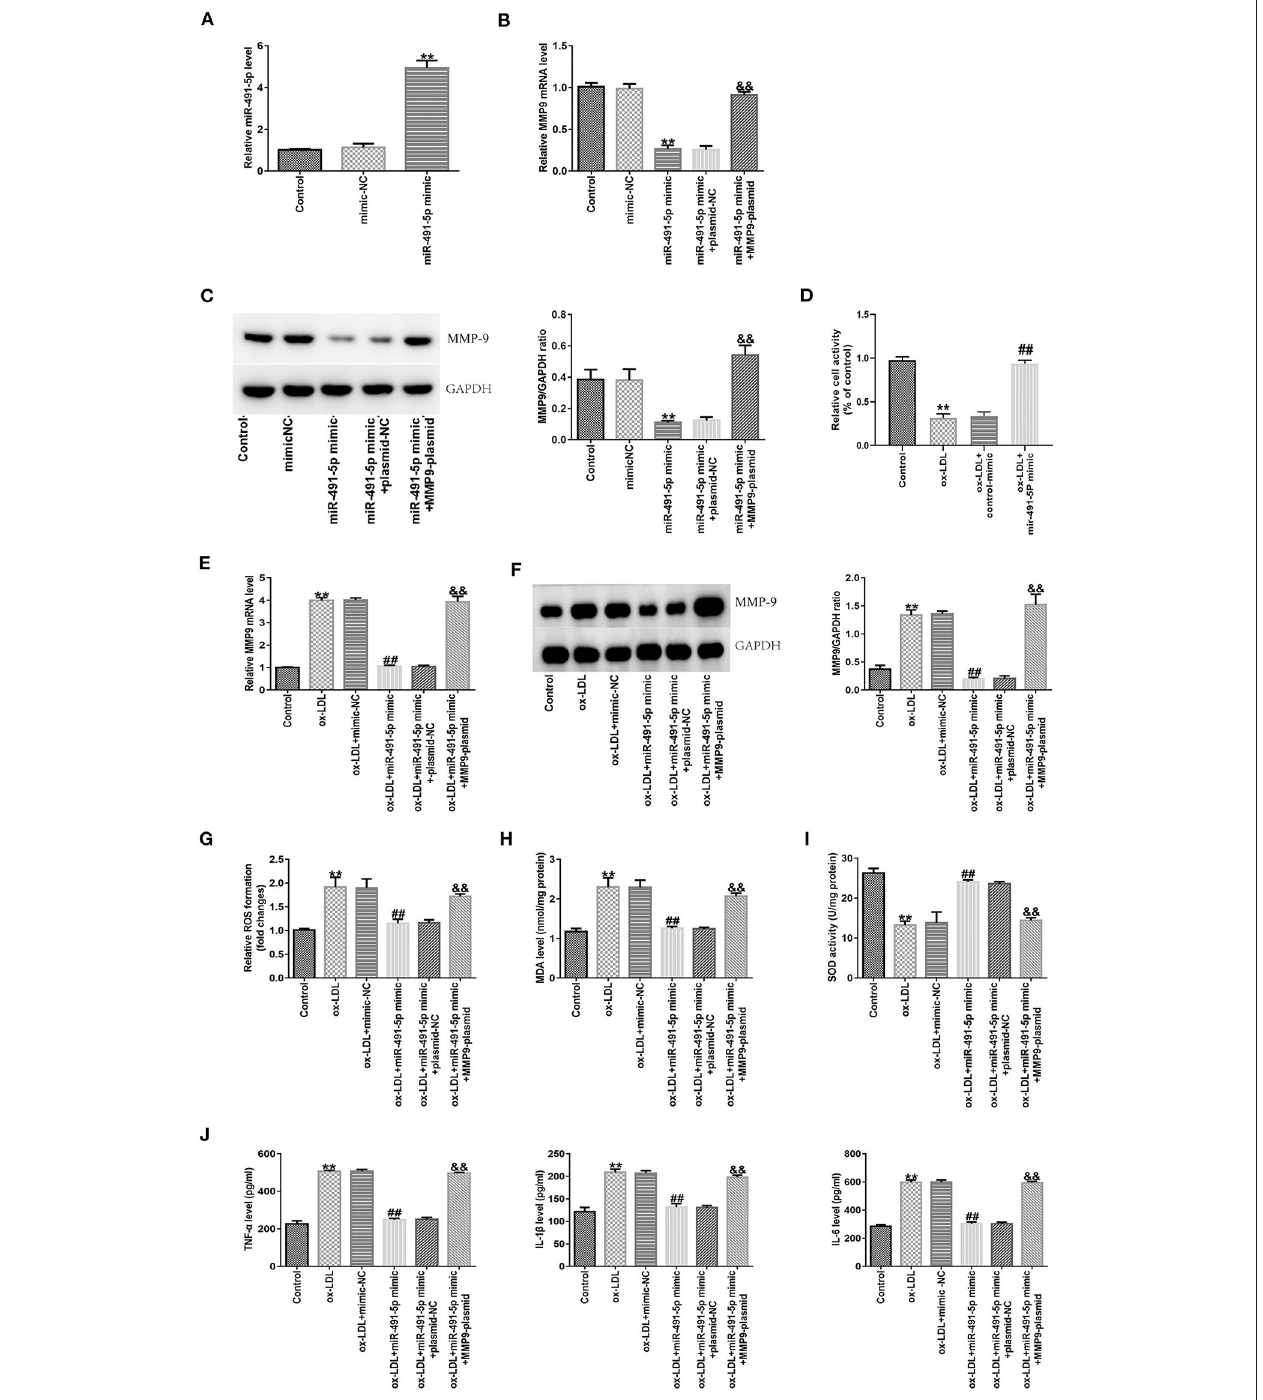
FIGURE 5 | Effect of miR-491-5p and MMP-9 on ox-LDL-induced THP-1 macrophages. (A) The transfection efficiency of miR-491-5P mimic was determined using qRT-PCR. (B,C) MMP-9 mRNA and protein levels were detected in THP-1 macrophages transduced with miR-491-5P and miR-491-5P mimic + MMP-9-plasmid. (D–J) Transfected THP-1 macrophages were stimulated with 50 µ g/mL ox-LDL. (D) Cell activity after mir-491-5P mimic transfection was assessed using CCK-8. (E,F) MMP-9 mRNA and protein were detected in ox-LDL-induced THP-1 macrophages transduced with mir-491-5p mimic and mir-491-5p mimic + MMP-9-plasmid. (G–I) ROS and MDA levels and SOD activity were examined using commercial kits. (J) Levels of inflammatory factors (TNF- α , IL-1 β , and IL-6) were measured with ELISA. Data are presented as the mean ± SD, n = 6. Compared with the control group, ** P < 0.01; compared with the ox-LDL + mimic-NC group, ## p < 0.01; compared with the ox-LDL + miR-491-5Pmimic + plasmid-NC group, && P < 0.01.